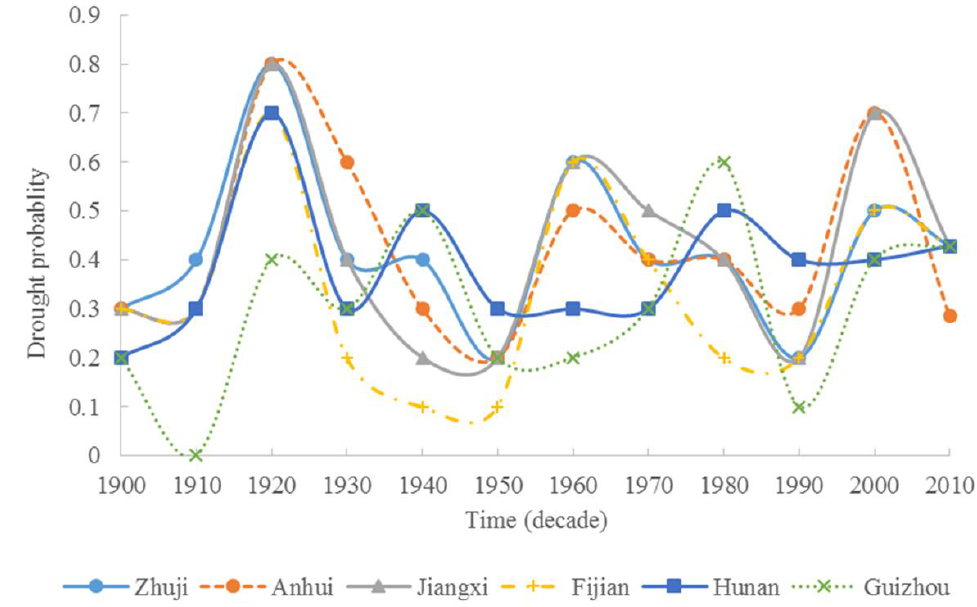
Figure 7. The drought probability in a decade scale among the six regions with Chinese Torreya plantations. (1910 means 1910s).